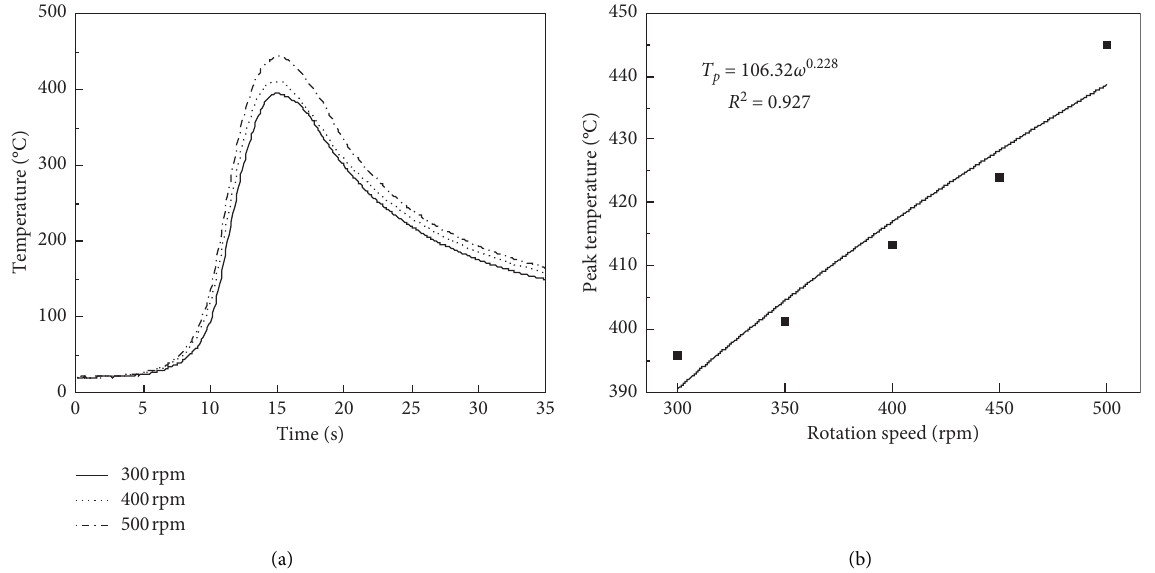
Figure 3: (a) Welding temperature measured at various rotation speeds. (b) The peak temperatures as a function of rotation